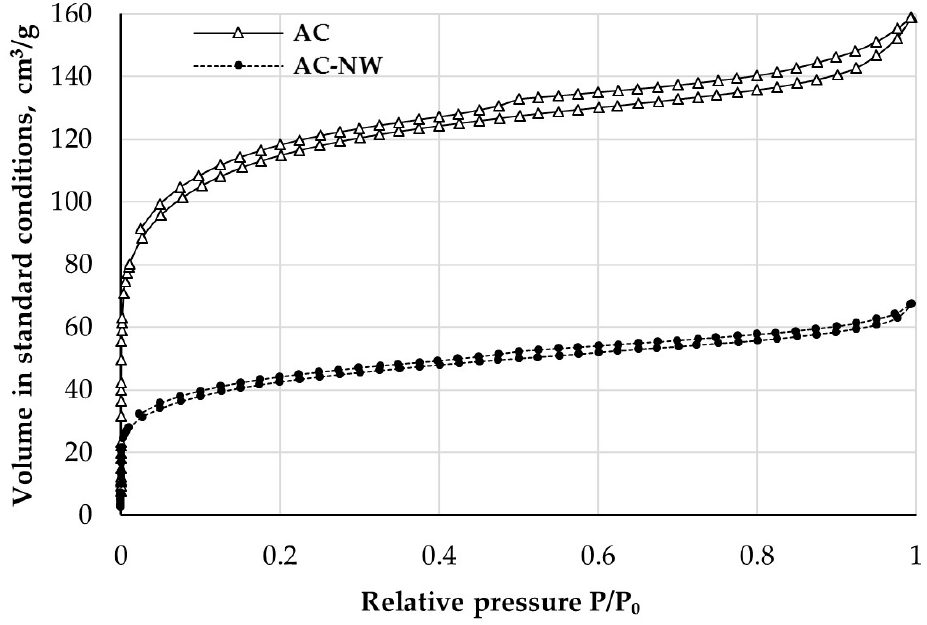
Figure 4. Nitrogen adsorption-desorption isotherms (77 K) of AC and AC-NW